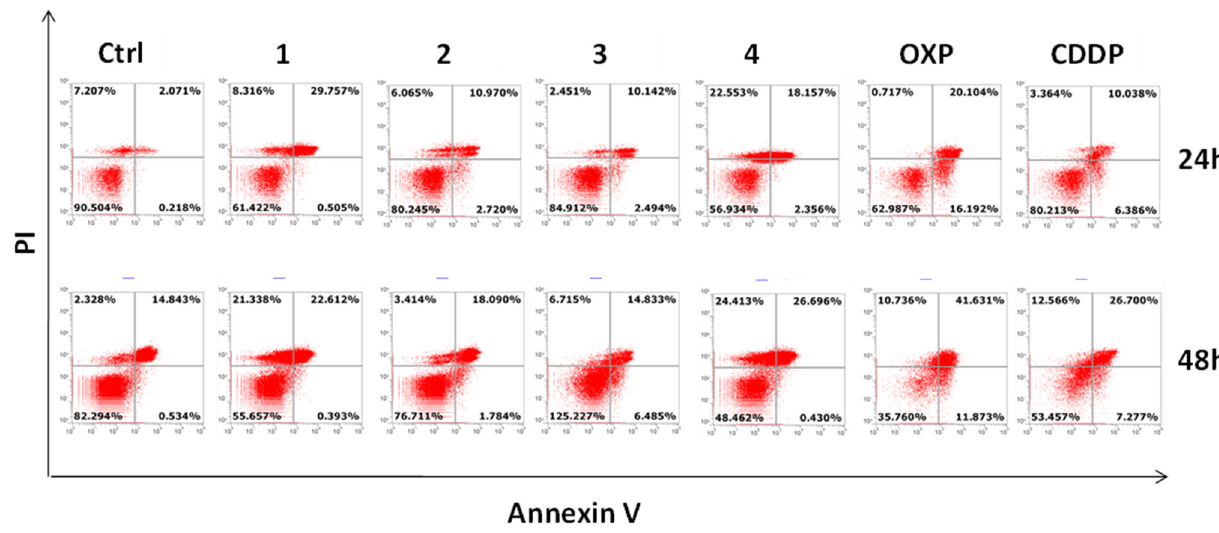
Figure 12. FCM dot plots of Annexin V/PI-positive HCT116 cells after 24 and 48 h incubation with compounds 1 – 4 , oxaliplatin (OXP), and cisplatin (CDDP) at their IC 50 concentrations (reported in Supplementary Table S1). The lower left quadrants of each panel show the viable cells. The upper left quadrants contain the necrotic cells. The upper right quadrants contain the late apoptotic cells. The lower right quadrants contain the early apoptotic cells. Each quadrant includes the corresponding % of cells measured by flow cytometry.